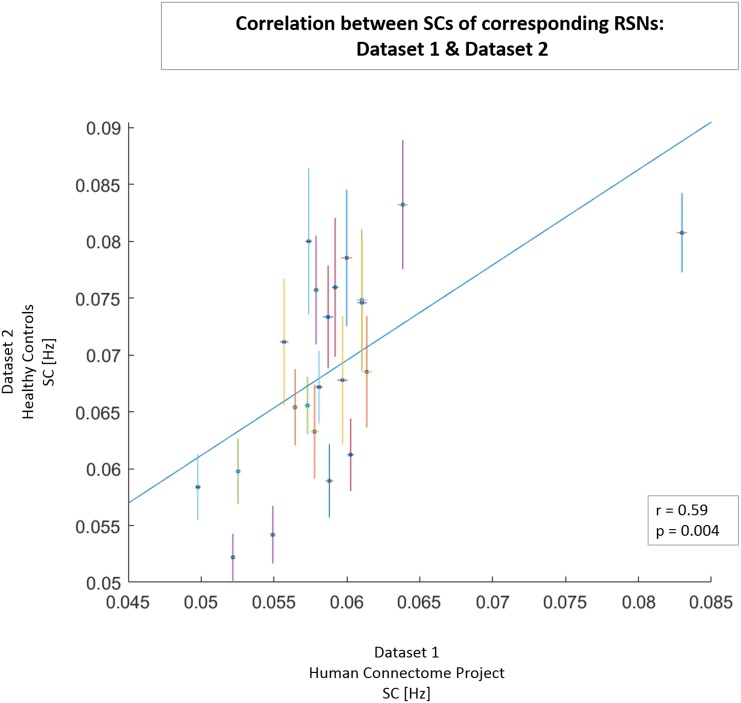
Correlation between SC values of 21 networks obtained from Dataset 1 from signal in frequency range of 0.01–0.25 Hz (x-axis) and the corresponding networks obtained from healthy controls in Dataset 2 (y-axis). For each network, the horizontal line represents the SEM in Dataset 1, and the vertical line represents the SEM in Dataset 2. A least-squares fit line was added to scatter plot. In the lower right box, correlation coefficient r and p-value are presented.